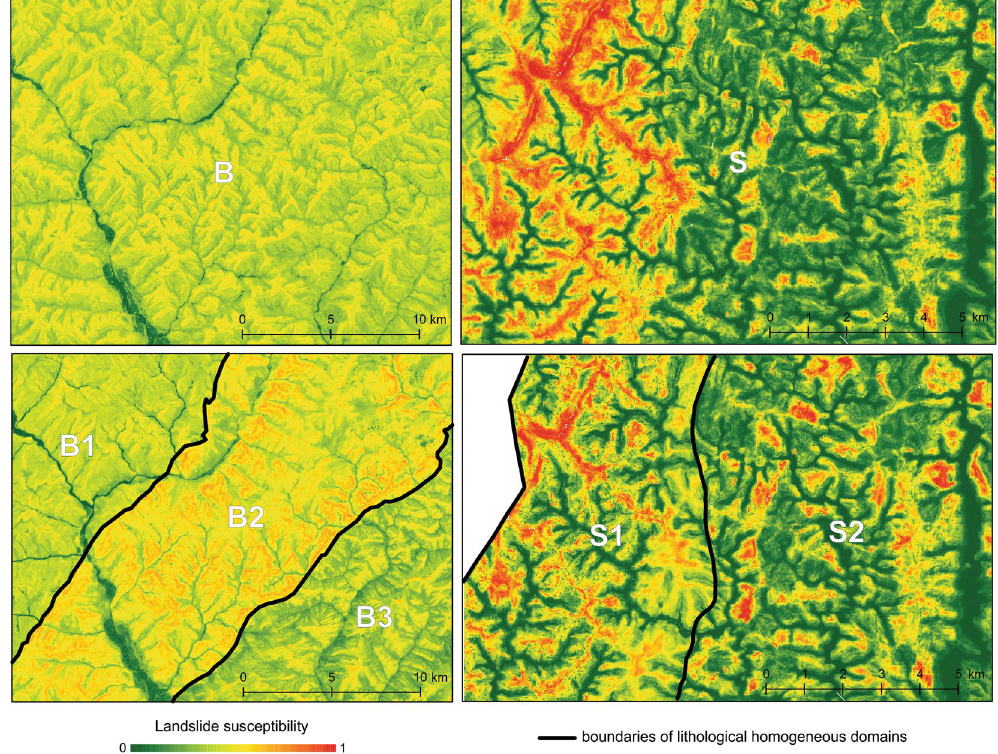
Figure 3. Landslide susceptibility maps in Buzău (left) and Shizuoka (right).